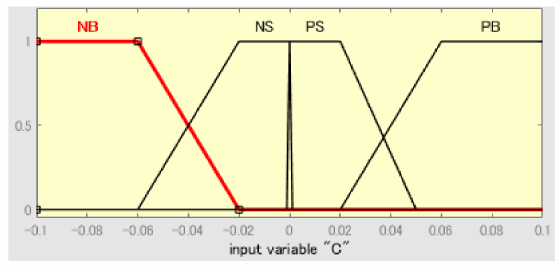
Figure 14. Wind turbine FLC input membership for C .